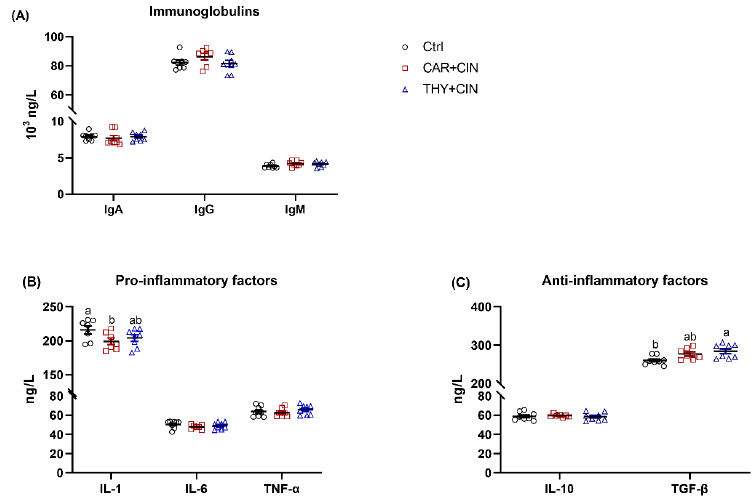
Figure 5. Impacts of the combination of cinnamaldehyde with carvacrol (CAR+CIN) or thymol (THY+CIN) on inflammatory status of laying hens: ( A ) immuneglobulins; ( B ) the pro-inflammatory factors interleukin (IL)-1, IL-6, and tumor necrosis factor alpha (TNF- α ); ( C ) the anti-inflammatory factors IL-10 and transforming growth factor beta (TGF- β) . Values are mean ± standard error (SE) represented by vertical bars ( n = 7 – 8). a,b Values without common superscript are notably different ( p < 0.05).